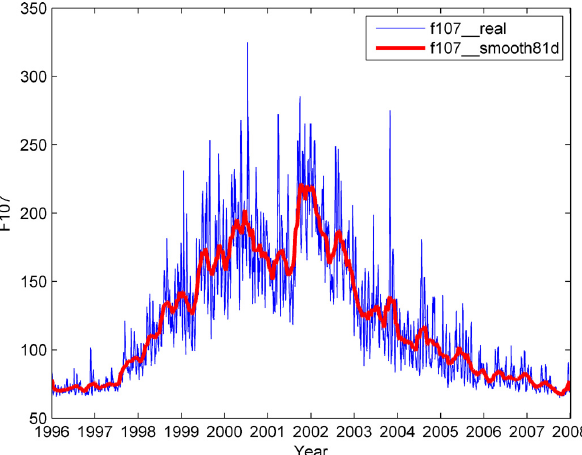
Fig. 1. The variation of F107 index from 1996 to